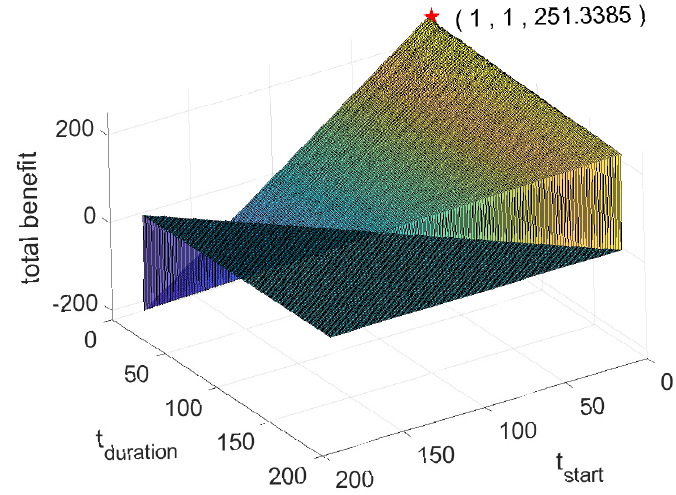
Figure 2. The results of the noreassignment algorithm.